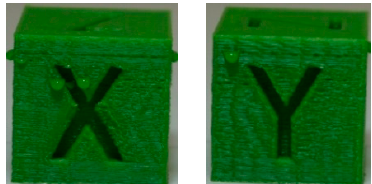
Figure 9. Blobs on surface of XYZ Calibration Cube printed on a cloud-based controller with large